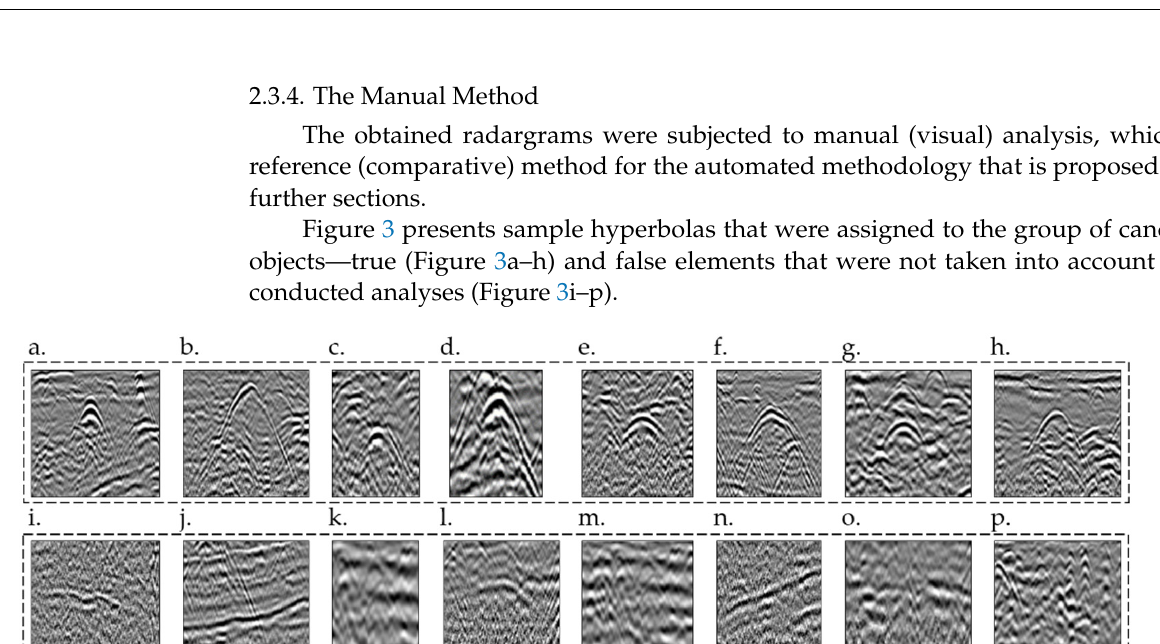
Figure 4. Manual classification of candidate objects.